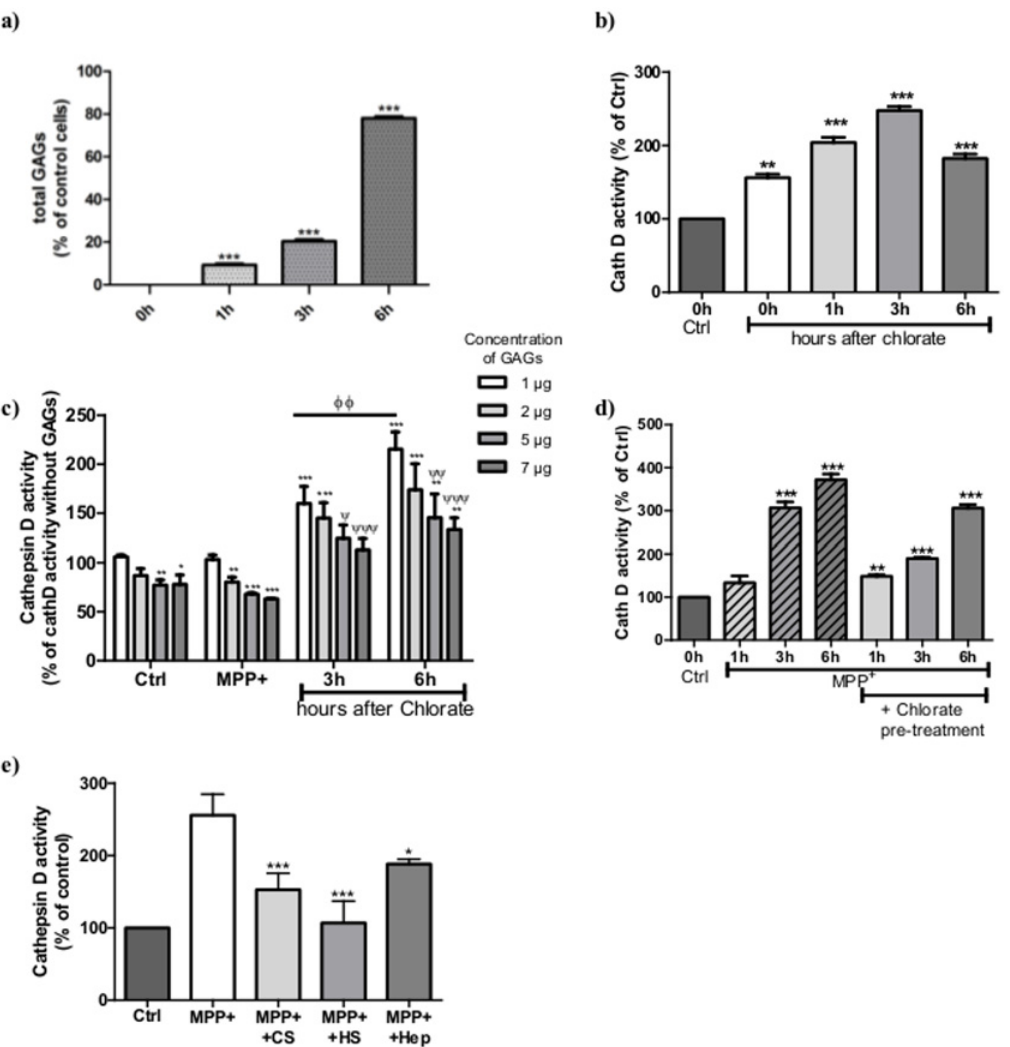
Figure 5. Regulation of cathepsin D activity by glycosaminoglycans. a) SH-SY5Y cells were treated with sodium chlorate (75 mM) during 24 h and sample were extracted at different times after sodium chlorate removal. GAGs amounts were measured in cells after 0, 1, 3 and 6 h after the end of the chlorate treatment. Results are presented as mean ± S.E.M. of three independent experiments in triplicate. *** p < 0.001 compared to control. b) Total cathD activity was measured at different times after sodium chlorate removal (75 mM, 24h). Results are expressed in percentage of cathD in normal cell extract and presented as mean ± S.E.M. of three independent experiments in triplicate. *** p < 0.001 compared to control cells. c) GAGs were extracted from control, MPP + -stressed cells, chlorate treated cells 3 and 6 h after chlorate removalas described in Material and Methods. GAG amounts were measured by DMMB assay [27]. The activity of cathD was measured in the presence of various concentrations of these extracted GAGs (white bars: 1 μ g/mL; light grey2 μ g/mL, medium grey:5 μ g/mL and dark grey: 7 μ g/mL) and expressed as the percentage of the specific CathD activity. Results are mean ± S.E.M. of three independent experiments in duplicate. ** p < 0.005; *** p < 0.001 compared to control cathD activity, ψ p < 0.01; ψψ p < 0.005; ψψψ p < 0.001 compared to results obtained with 1 μ g/mL of GAGs, ΦΦ p < 0.005 comparison between 3 and 6 h extracted GAGs. d) Total cathD activity was measured after different times (0, 1, 3 and 6 h) of treatment with MPP + (0.5 mM) with or without pre-treatement of cell with chlorate (75 mM, 24h). CathD activity was normalized by cell number in each sample and expressed as percentage of the activity in normal cells. ** p < 0.005; *** p < 0.001 compared to control. e) CathD activity in cells subjected or not to MPP + stress (6 h) and followed by commercial GAGs treatment (Hep, HS and CS, 1 μ g/mL). After 24 h, GAGs effects were compared to the complete inhibition of cathepsin activity by pepstatin A (peps), a specific inhibitor of this enzyme and expressed as percentage of cathD activity in control